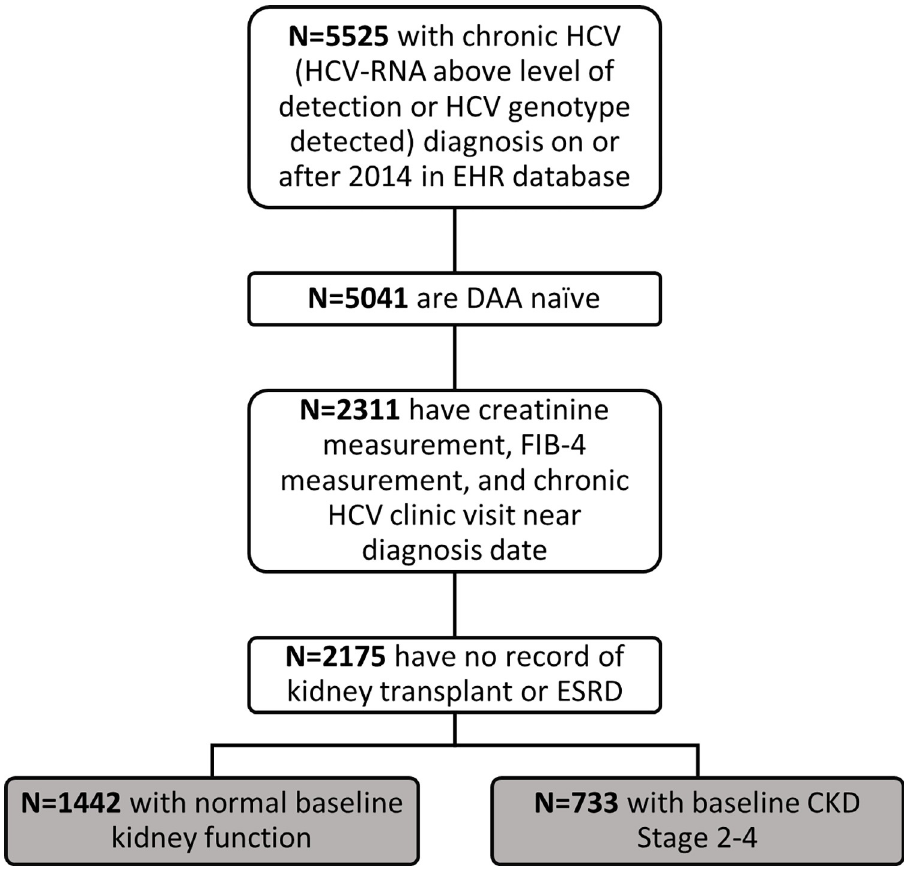
Fig 1. Flow chart of study